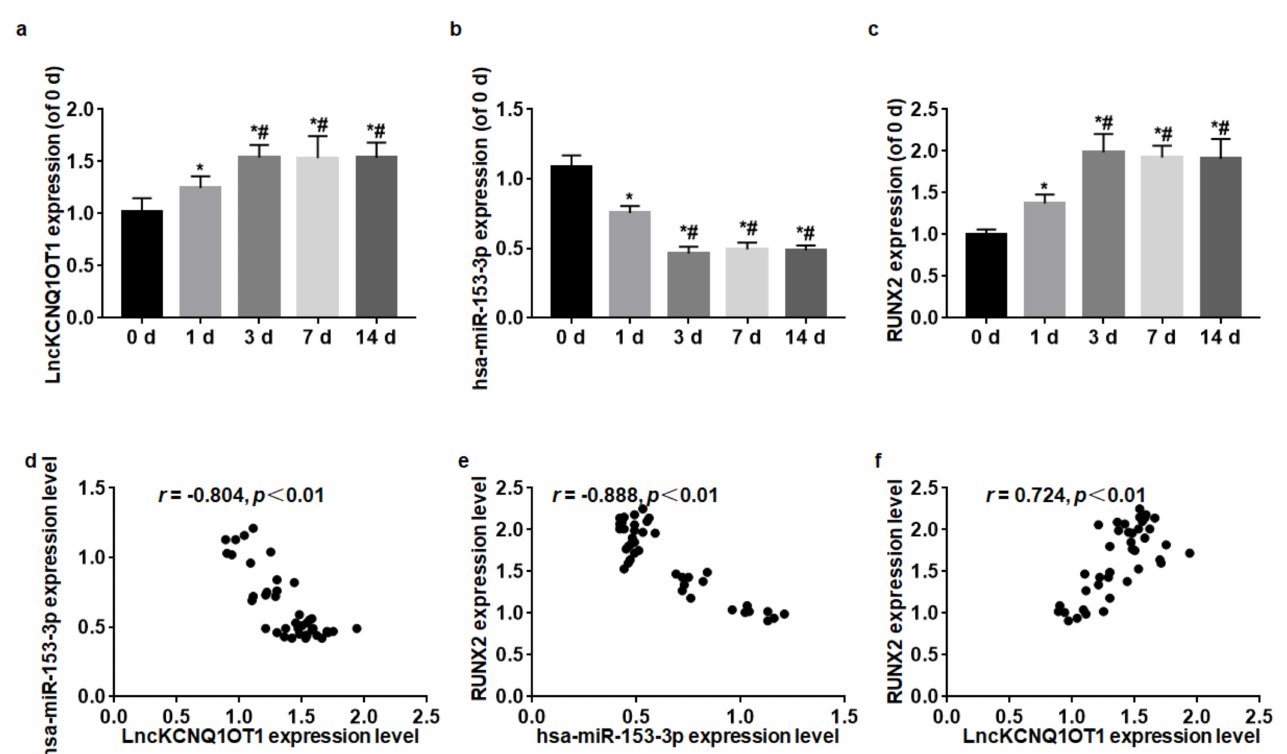
Figure 1. LncKCNQ1OT1, hsa-miR-153-3p, and RUNX2 expression levels during odontoblastic differentiation were detected by qRT-PCR. ( a ) On 1 d of differentiation of odontoblasts, the expression of LncKCNQ1OT1 increased and reached a peak at 3 d. ( b ) On 1 d of differentiation of odontoblasts, hsa-miR-153-3p expression level decreased and reached a peak at 3 d. ( c ) On 1 d of differentiation of odontoblasts, the expression of RUNX2 increased and reached a peak at 3 d. ( d ) LncKCNQ1OT1 expression level was negatively correlated with hsa-miR-153-3p expression level. ( e ) hsa-miR-153- 3p expression level was negatively correlated with RUNX2 expression level. ( f ) LncKCNQ1OT1 expression level was positively correlated with RUNX2 expression level. * vs. 0 d, p < 0.05; # vs. 1 d, p <